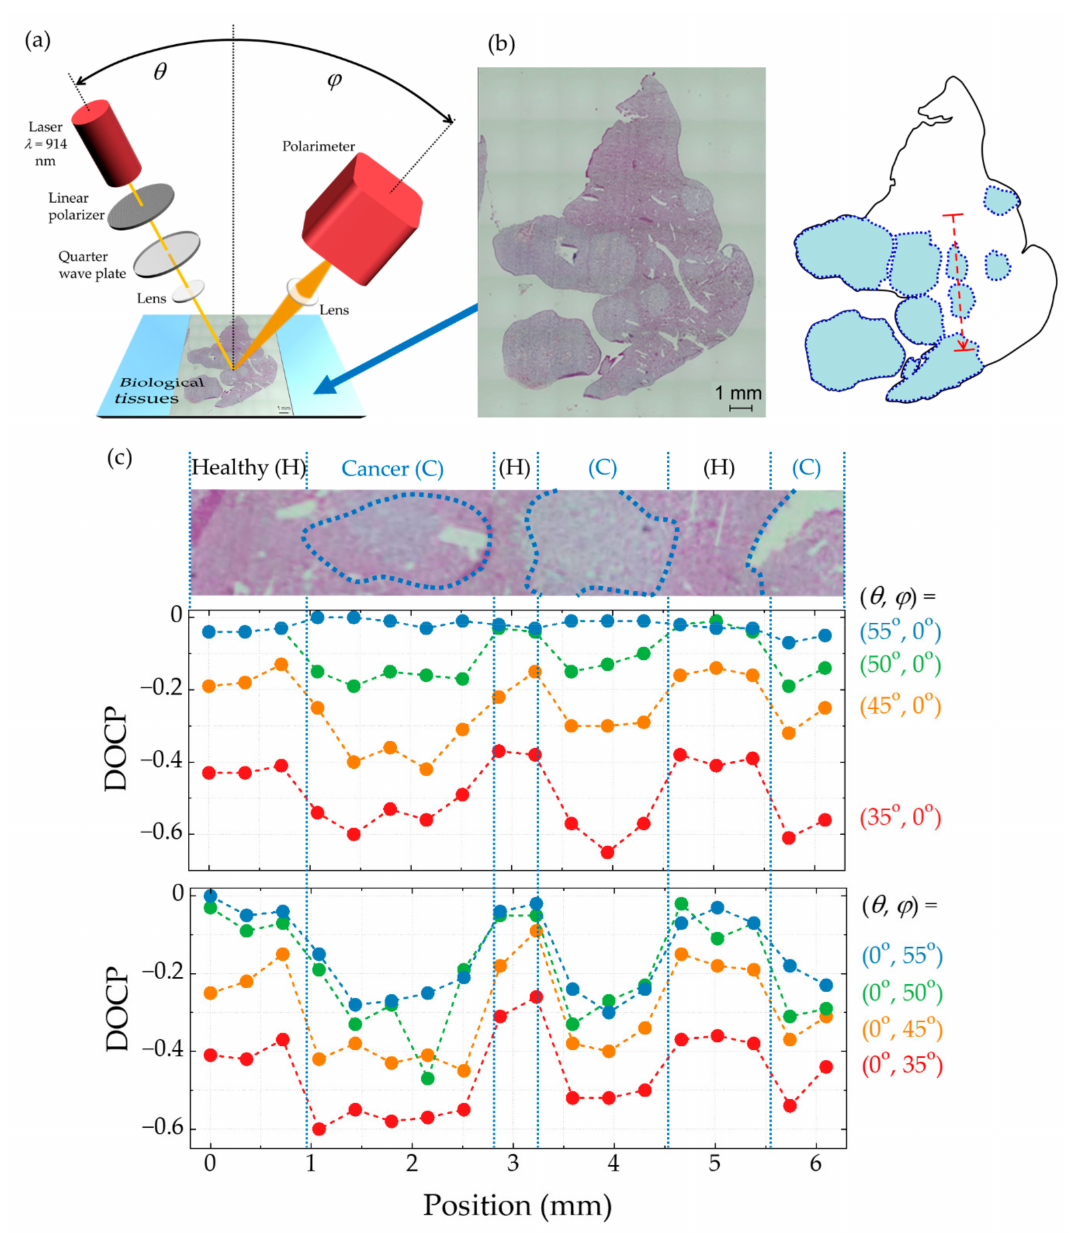
Figure 10. ( a ) Schematic illustration of the experimental setup for CPL illumination and measurement of DOCPs of the scattered light with various angular configurations. ( b ) (left) a micrograph of specimen and (right) a corresponding schematic map. The light blue areas delineated by the blue dotted lines represent the cancerous parts. The red arrow shows the area across healthy and cancerous parts in which line-scanning experiments were performed. (c) Results of the line-scanning experiments with different (upper) incident angles θ with φ = 0 ◦ and detection angles φ with θ = 0 ◦ along the red arrow shown in ( b ). The micrograph of the scanning area in the upper part corresponds to the probing points. Reproduced with permission from